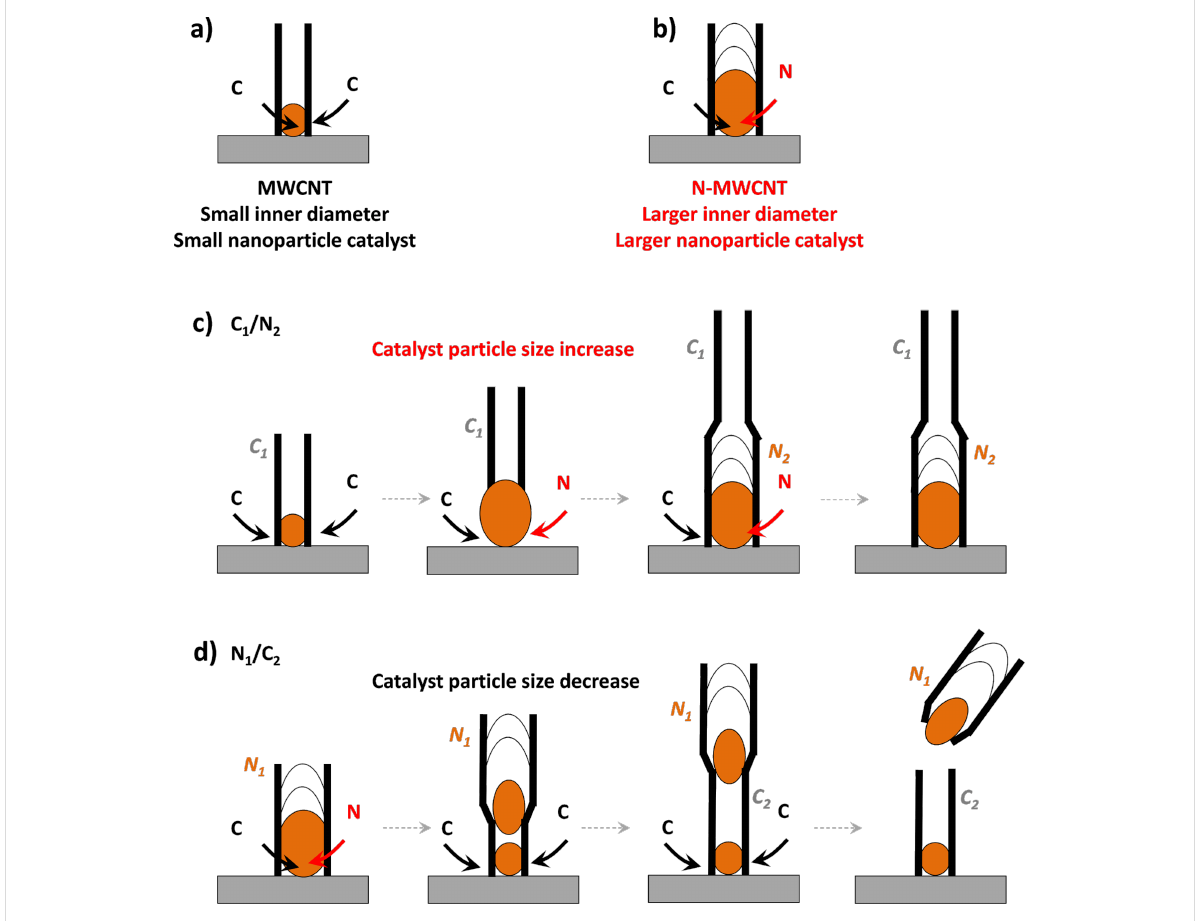
Figure 5: Schematic representing the growth mechanism and the relation between inner diameter and catalyst nanoparticle size and position for (a) MWCNT, (b) N-MWCNT, (c) C 1 /N 2 , and (d) N 1 /C 2 MWCNT structures.